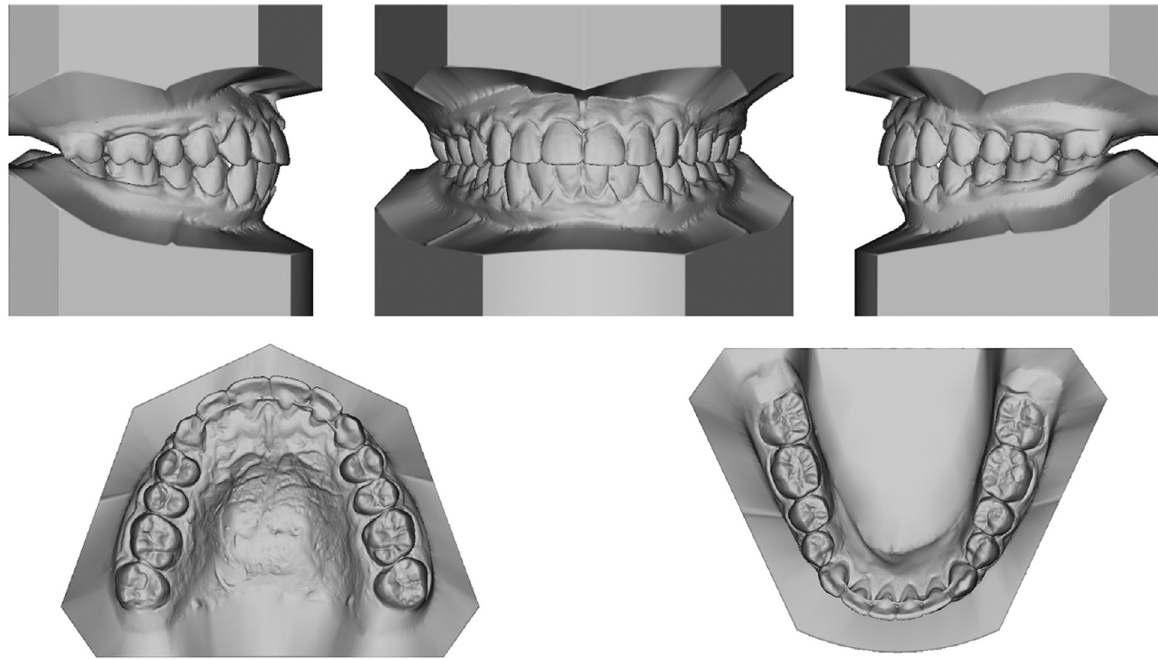
Figure 9. Post-treatment